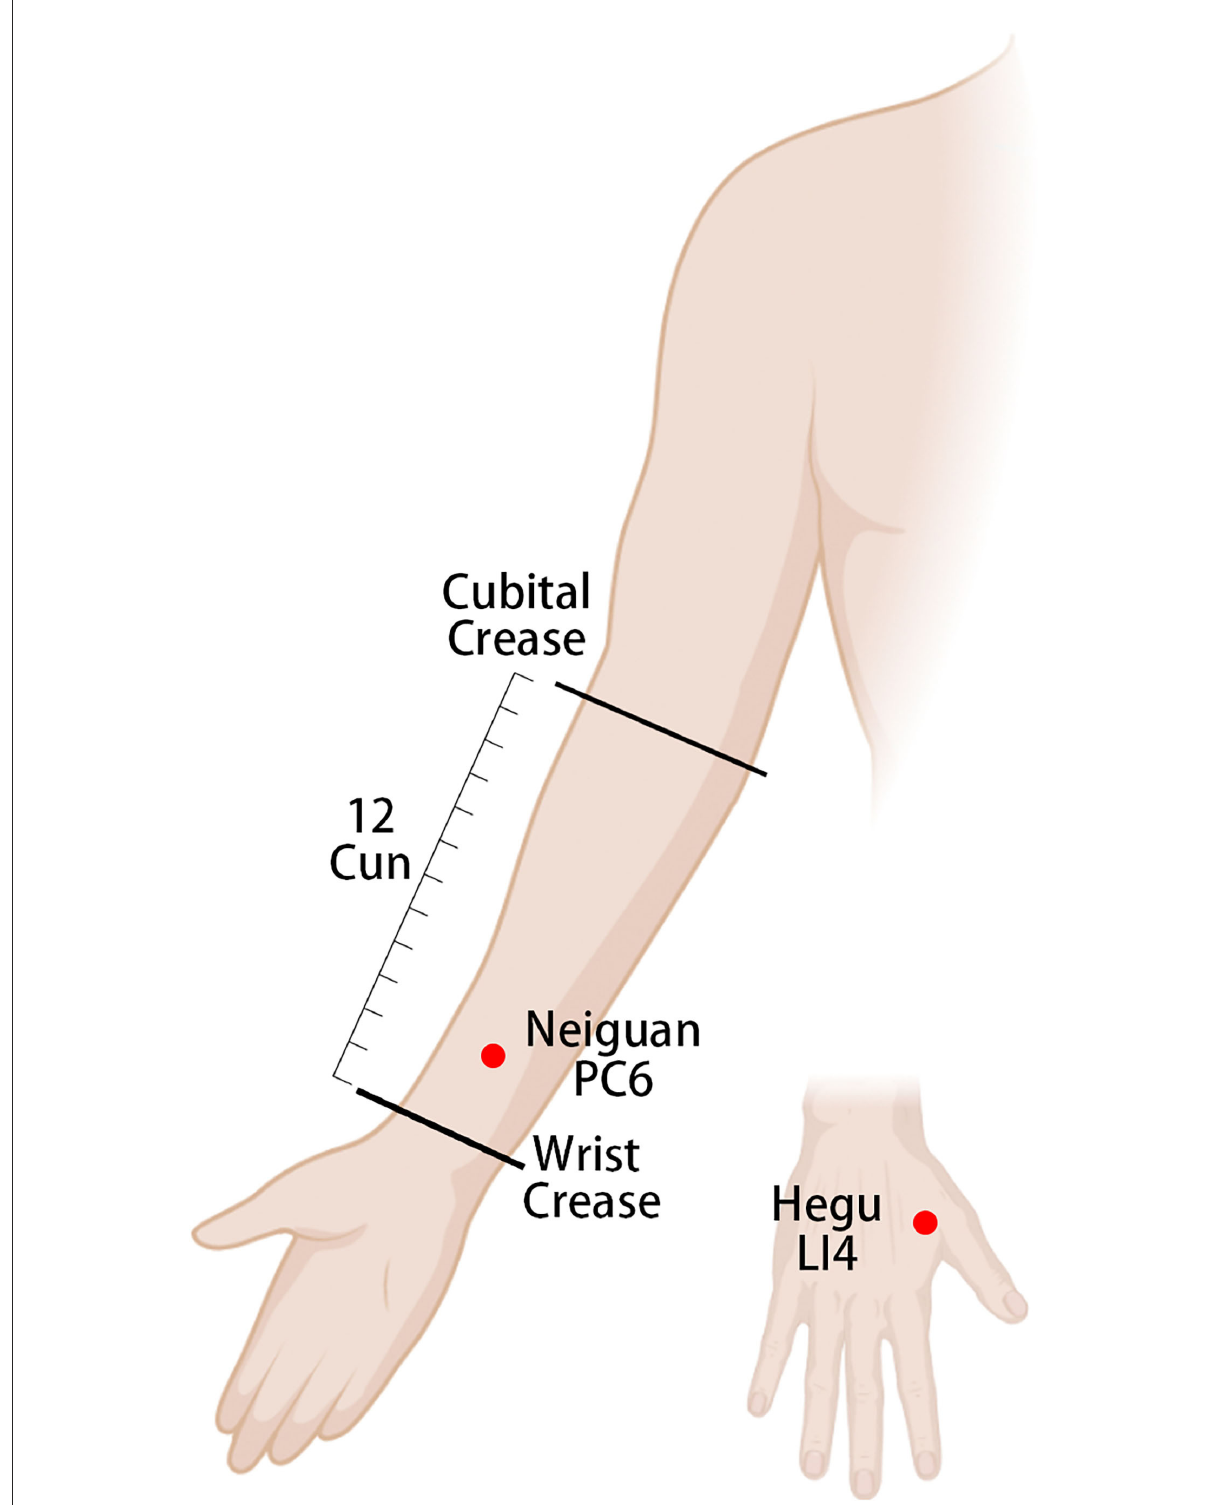
FIGURE3 Location of upper extremity acupoints and electrode connection. PC6 (Neiguan) on the volar aspect of the forearm, 2 cun on the wrist crease, and between the palmaris longus tendon and the flexor carpi radialis tendon. LI4 (Hegu) between the first and second metacarpals, at the midpoint of the radial aspect of the second metacarpal. A set of electrodes is attached at the red dot